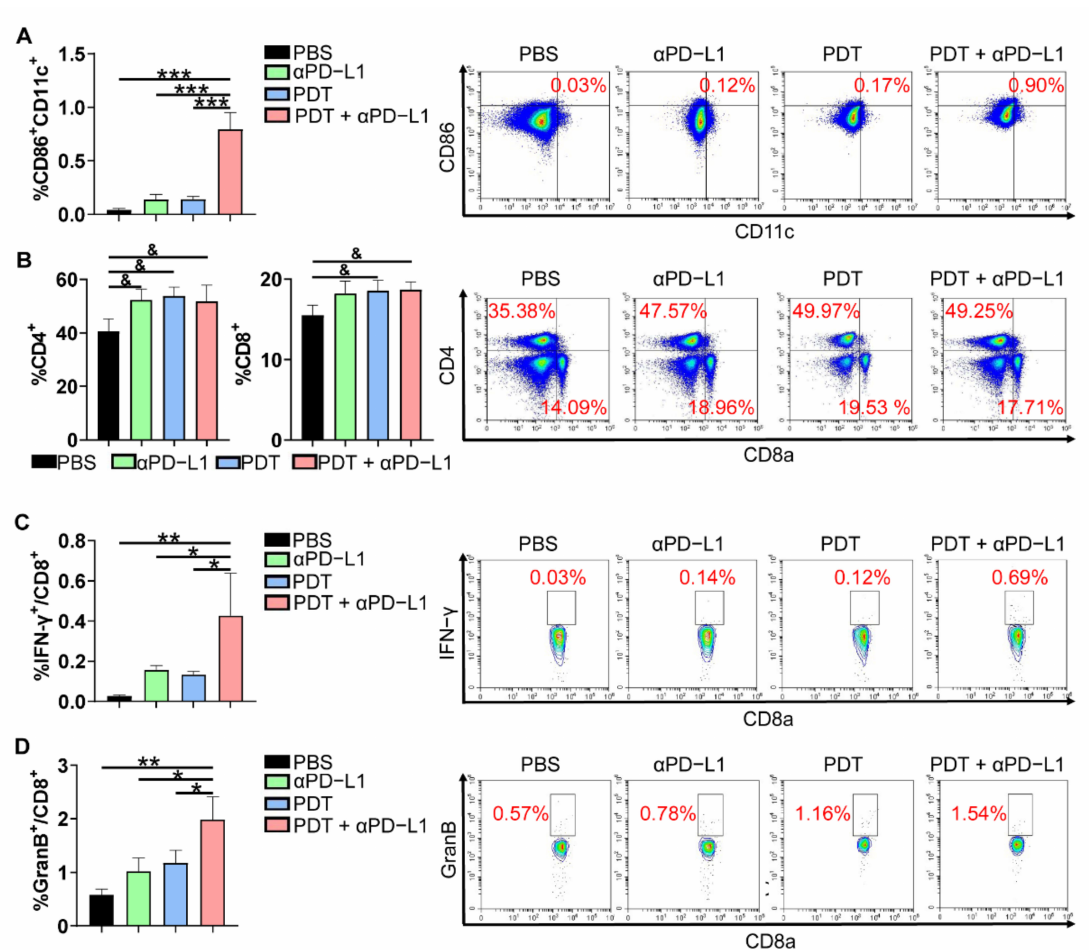
Figure 7. Flow cytometry analysis of various immune cells in the DLNs in the 4T1–bearing mice following different treatment. ( A ) Percentage of mDCs, ( B ) CD4 + and CD8 + cells, ( C ) IFN– γ + in CD8 + cells, and ( D ) CD8 + GranB + cells in the DLNs, respectively. The therapeutic regimen was shown in Supplementary Figure S5. The representative flow cytometric histograms and their gating strategies are shown on the right. Data are presented as mean ± SD ( n = 3). * p < 0.05, ** p < 0.01 and *** p < 0.001 compared with the PDT + α PD–L1 group. & p < 0.05 compared with the PBS